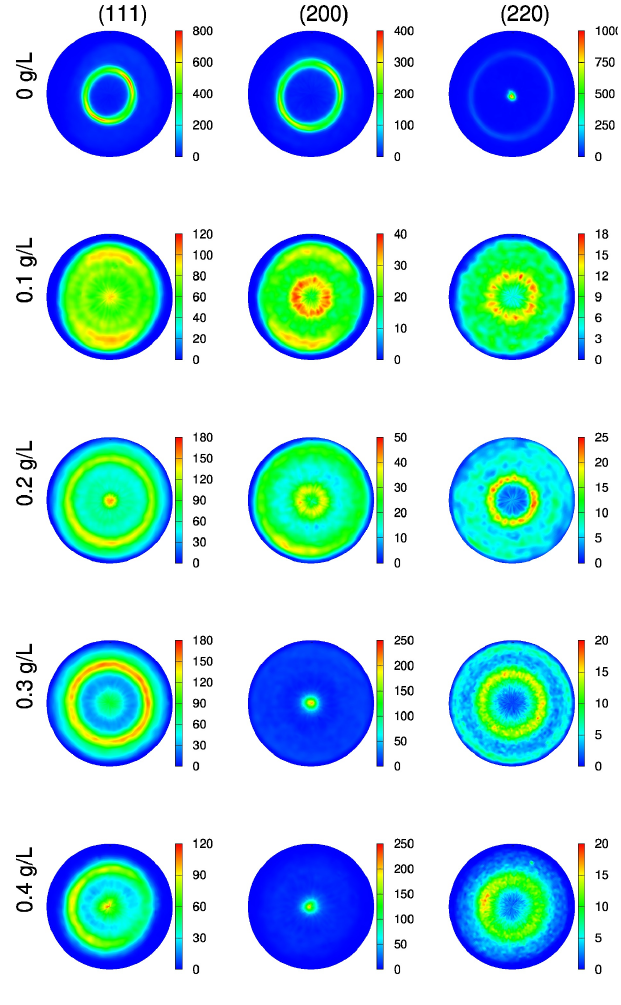
Figure 5. (111), (200) and (220) pole figures obtained by XRD for the “es” side of the Ni films deposited with different cysteine